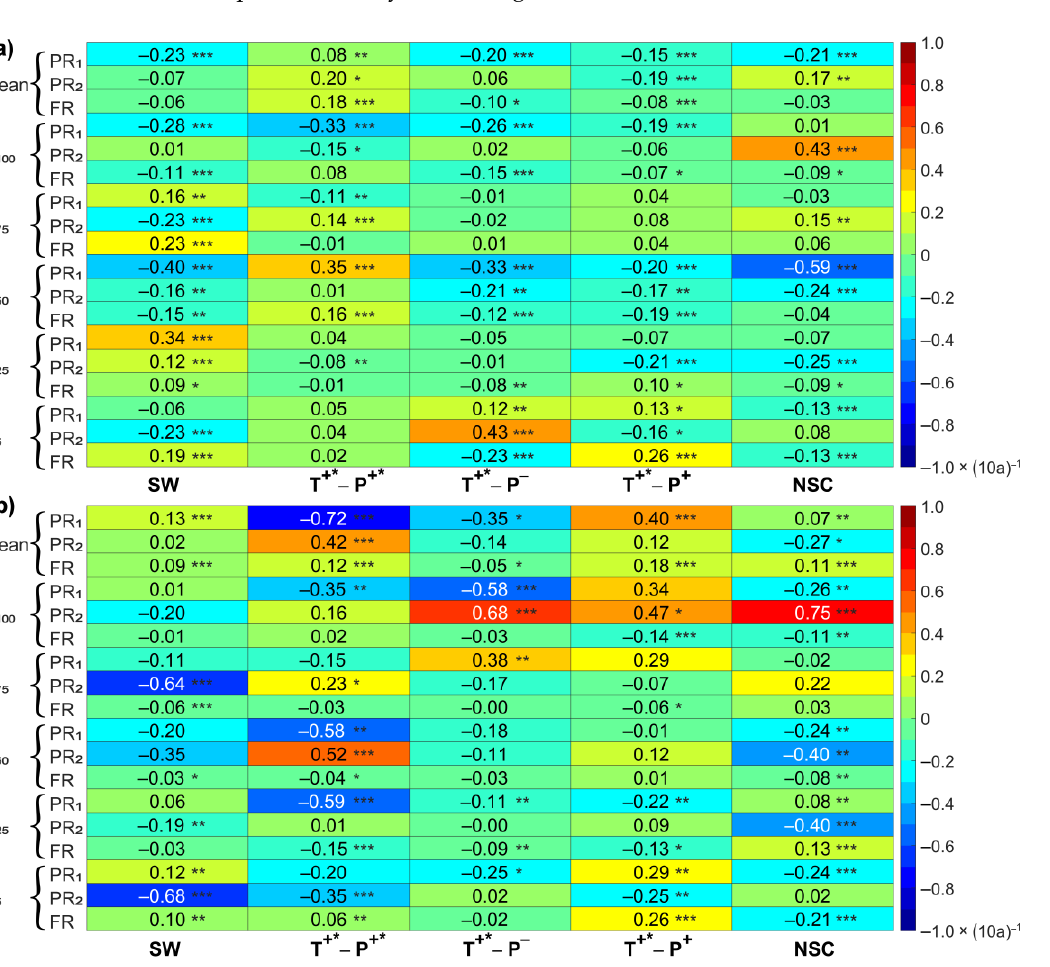
Figure 5. The variation tendency of the correlation coefficient between NDVI and temperature and precipitation in a 15-year period considering ( a ) the same period, ( b ) the annual, and ( c ) the interannual time lag. PR 1 and PR 2 represent the partial correlation coefficient between NDVI and temperature and precipitation, respectively, and FR represents the multiple correlation coefficient. “ * ” , “ ** ” , and “ *** ” demonstrate the importance of p < 0.1, p < 0.05, and p < 0.01, respectively.